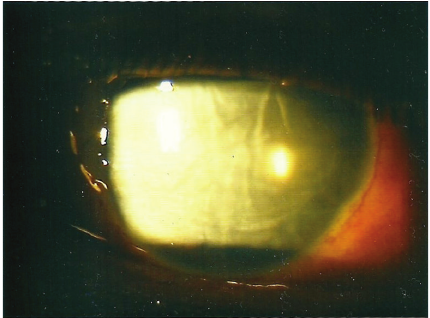
Figure 3: Reappearance of EK button (slightly decentered) and resolution of corneal oedema.